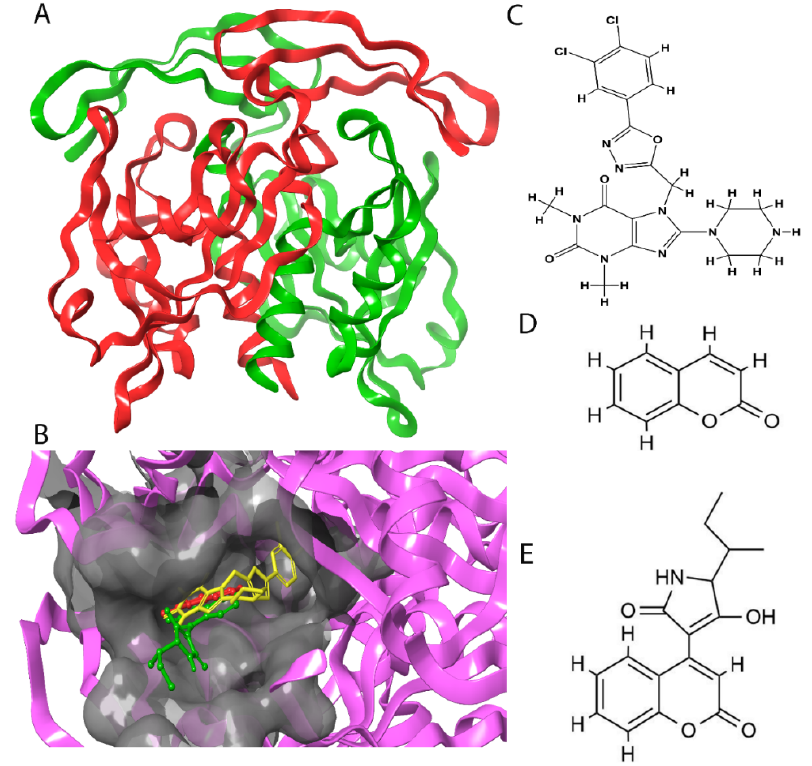
Figure 1. Structure visualization of receptors and compounds. ( A ) Three-dimensional structure of 5WNH with chain A highlighted in red and chain B highlighted in green. ( B ) Binding pose comparison of the binding mode comparison of TH5427 (green), coumarin (red), and principal compound (coumarin derivative, yellow) along with the protein (faded salmon). The binding pocket/surface is shown in gray. Both images A and B were obtained from Maestro v13.2. ( C ) Two-dimensional Fischer representation of TH5427. ( D ) Two-dimensional Fischer representation of coumarin. ( E ) Two-dimensional Fischer representation of coumarin derivative (principal compound).